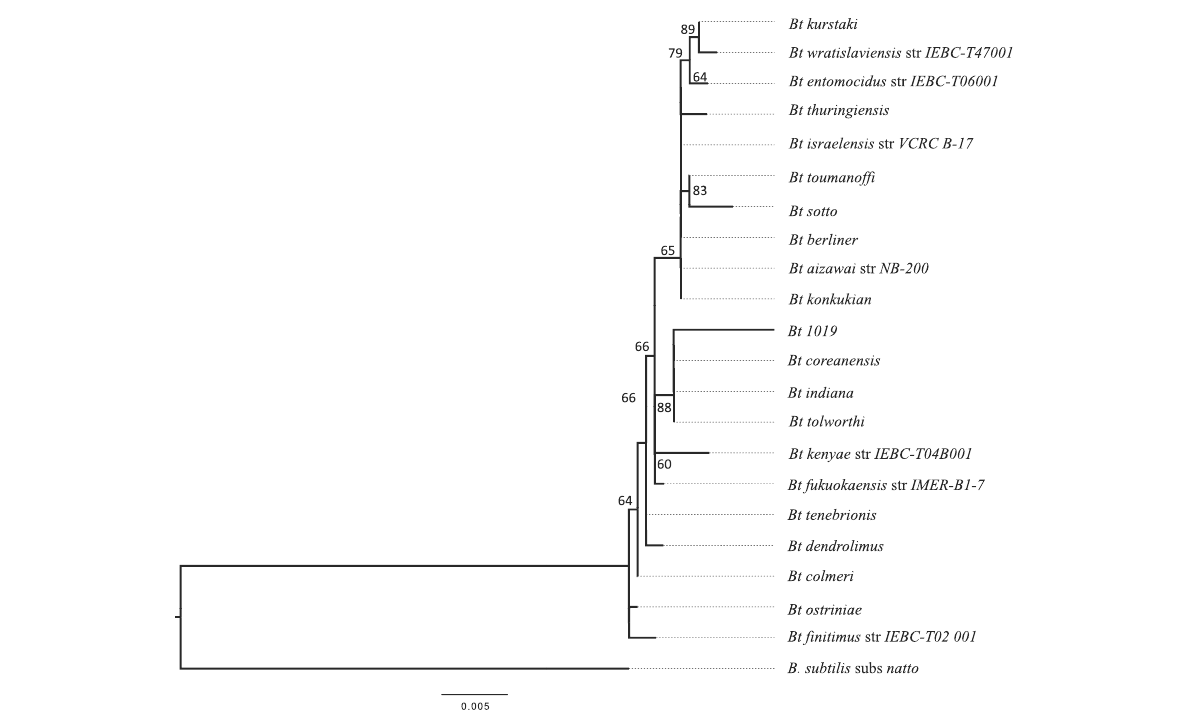
Fig. 4 Phylogenetic tree of 20 Bacillus thuringiensis isolates obtained from NCBI along with the native isolate (1019) and Bacillus subtilis subspecies natto as an out-group showing relationships between the alignment of the 1450 bp of 16S-ITS rDNA region. The horizontal bar represents 0.05% variation in nucleotide identities